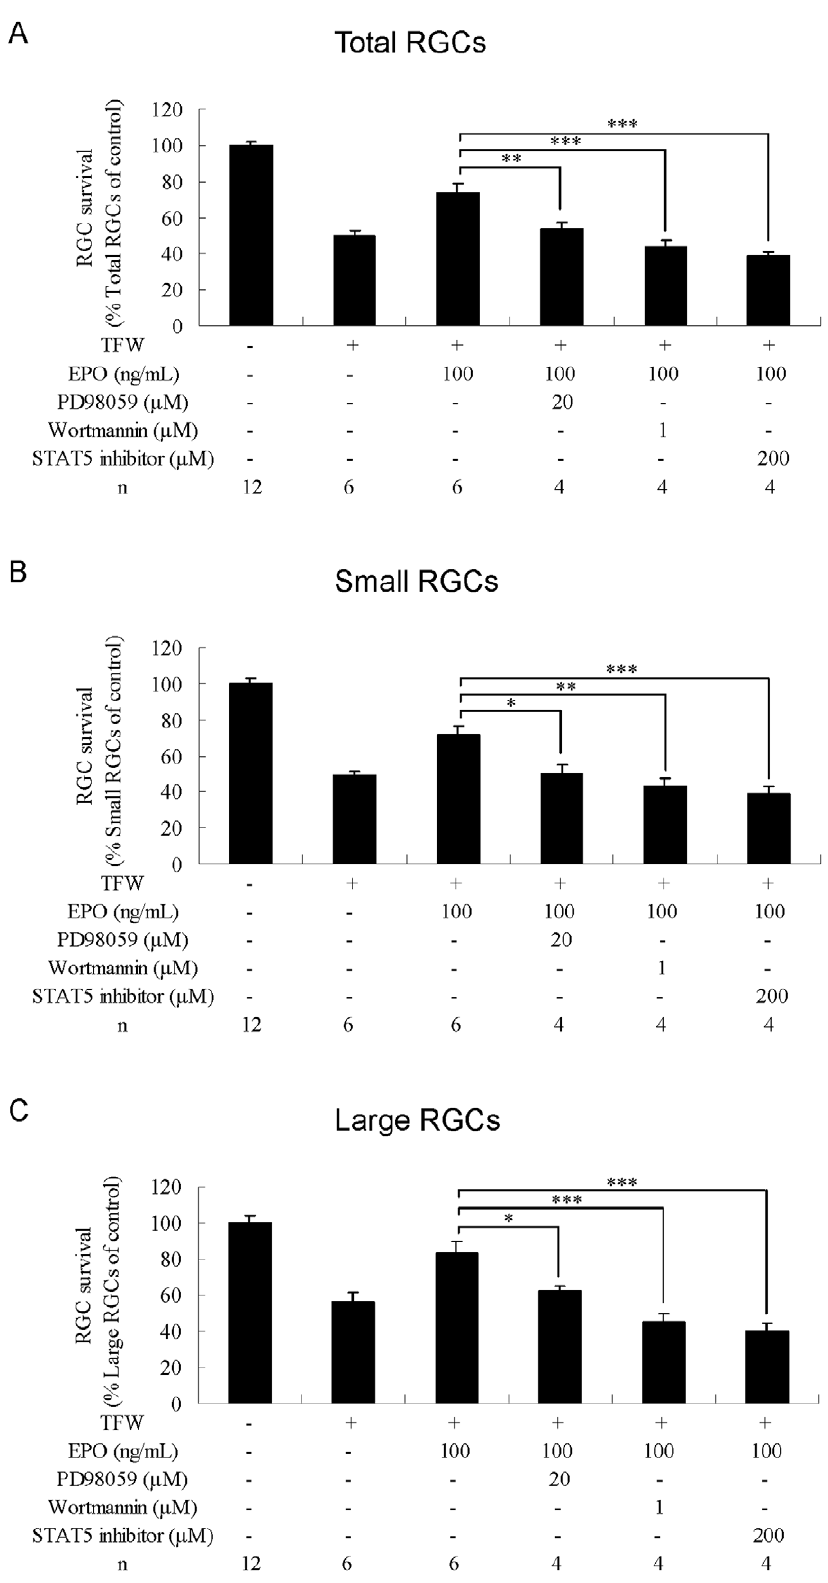
Figure 6. Effects of combined treatment with erythropoietin and kinase inhibitors on RGCs under TFW-induced toxicity. Survival rates of (A) total, (B) small, and (C) large RGCs were estimated as percentages of the control. Data are presented as mean 6 standard error of the mean (n=6–12). Data were statistically analyzed by 1-way ANOVA, followed by the Dunnett’s test. *P , 0.05, **P , 0.01 and ***P , 0.001.